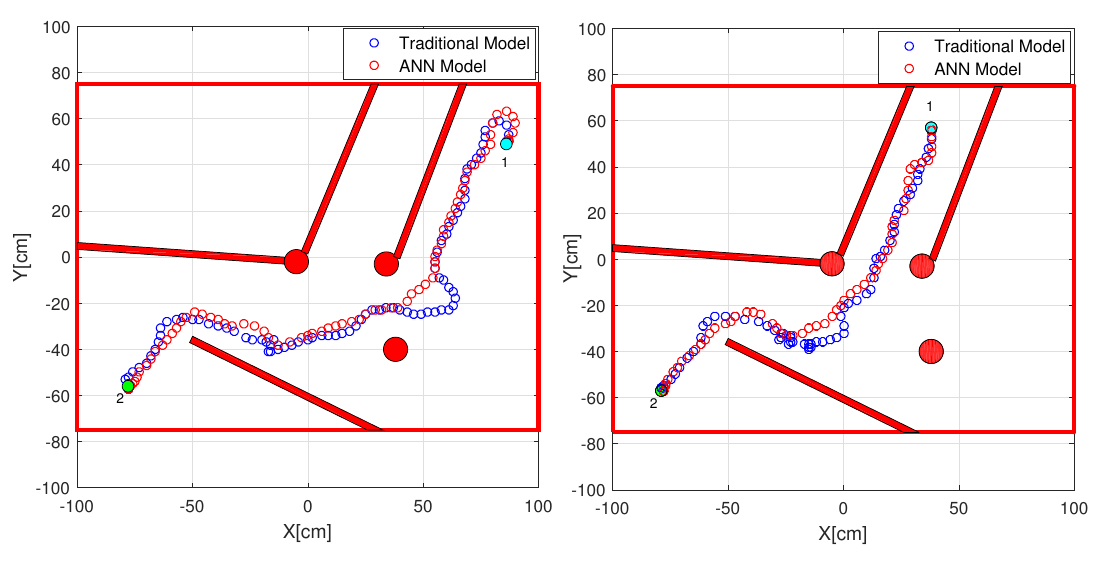
Figure 18. Obstacles avoidance experiment results for Robot 2.